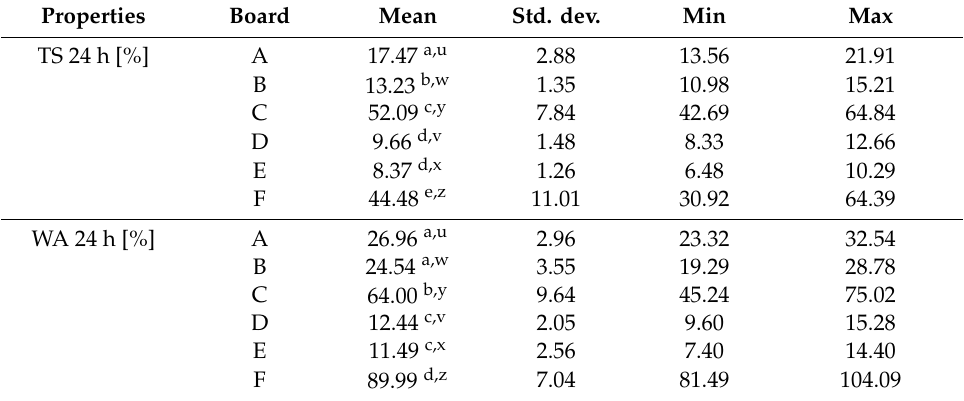
Table 5. Physical properties of the hazelnut, walnut, and spruce particle